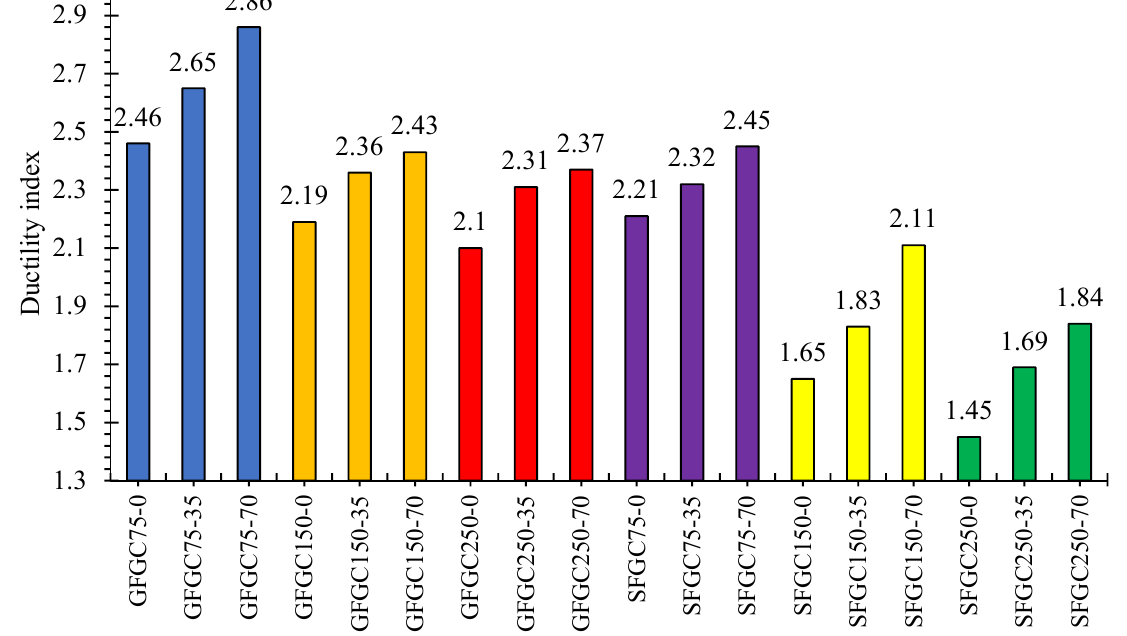
Figure 12. Ductility indices for several GFGC and SFGC specimens.